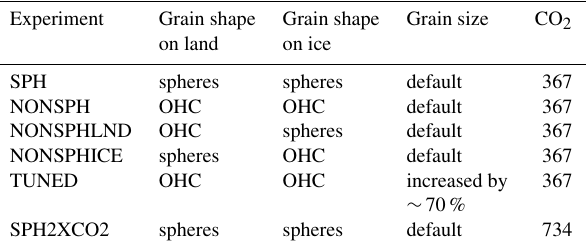
Table 1. List of experiments conducted. The columns 2 to 5 give snow grain shape on land and sea ice, the grain size parameteriza- tion, and atmospheric CO 2 concentration (ppmv). OHC refers to the optimized habit combination (Räisänen et al., 2015) and “default” to the default parameterization of snow grain size in SNICAR and